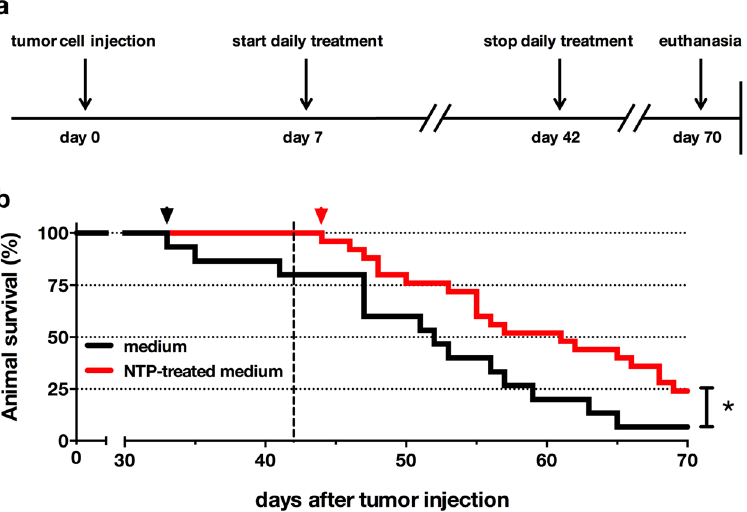
Figure 6. NTP-treated medium significantly enhanced survival in tumor-bearing animals. The experimental timeline for animal survival is given ( a ). Lethal tumor growth ( b ) showed a later onset (arrowhead) in the treatment (44 days) compared to the control group (33 days). Overall survival was significantly enhanced. Kaplan-Mayer survival curve is representative of 25 animals (NTP-treated medium) or 15 animals (medium), respectively. Dashed line indicates last treatment